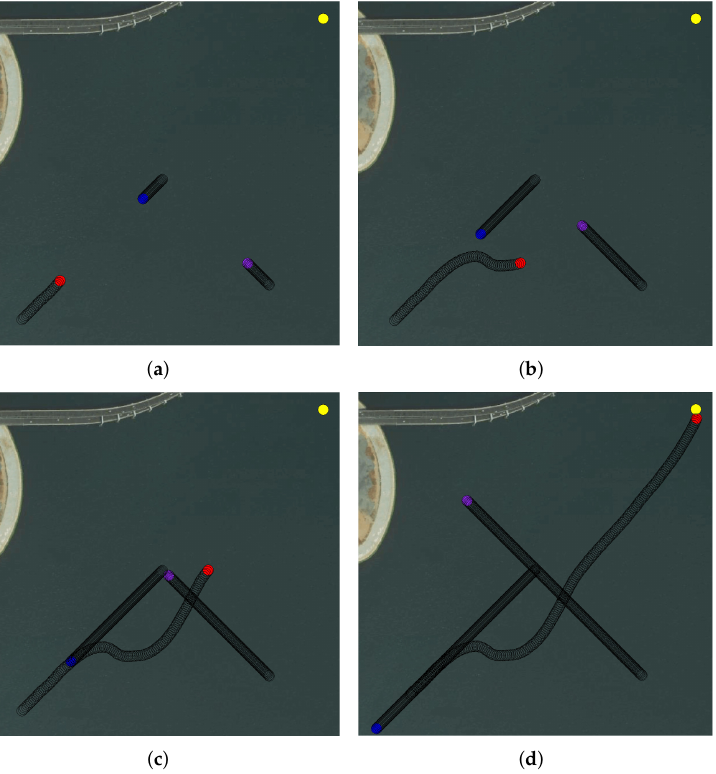
Figure 22. Multi-USV collision avoidance Simulation Environment 2. ( a ) Stage 1. ( b ) Stage 2. ( c ) Stage 3. ( d ) Stage